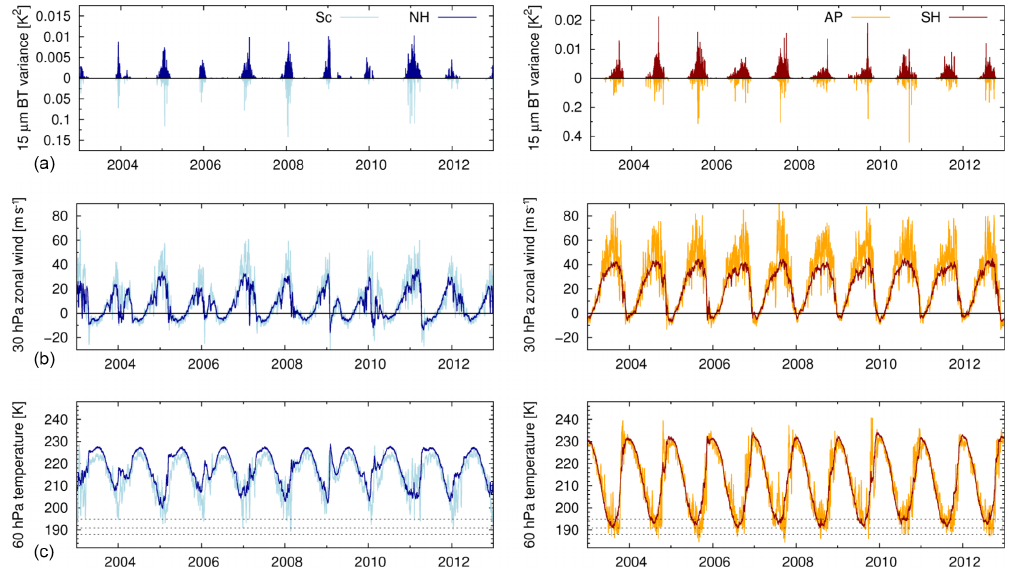
Figure 5. Time series of daily AIRS 15µm brightness temperature variances (top) as well as 6-hour ERA-Interim 30hPa zonal winds (middle) and 60hPa temperatures (bottom) at Northern Hemisphere mid- and high latitudes (NH; 55–85 ◦ N), the Scandinavian Mountains (Sc; 56–64 ◦ N and 4–20 ◦ E), Southern Hemisphere mid- and high latitudes (SH; 85–55 ◦ S), and the Antarctic Peninsula (AP; 68–60 ◦ S and 68–52 ◦ W). The dotted lines indicate typical PSC existence temperatures of T ice = 188K, T STS = 191K, and T NAT = 195K at 20km of altitude (Pawson et al.,